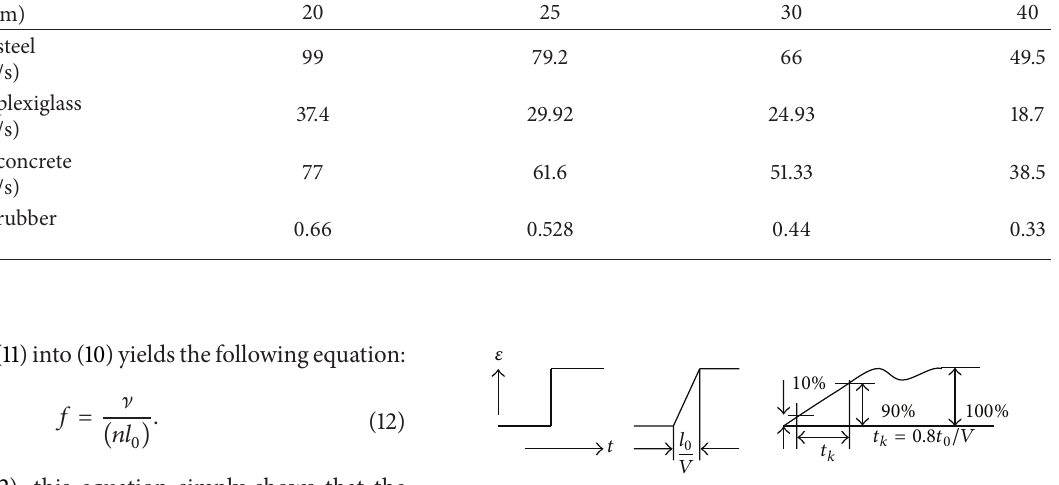
Figure 2: The response property of FBG strain sensor to step wave.